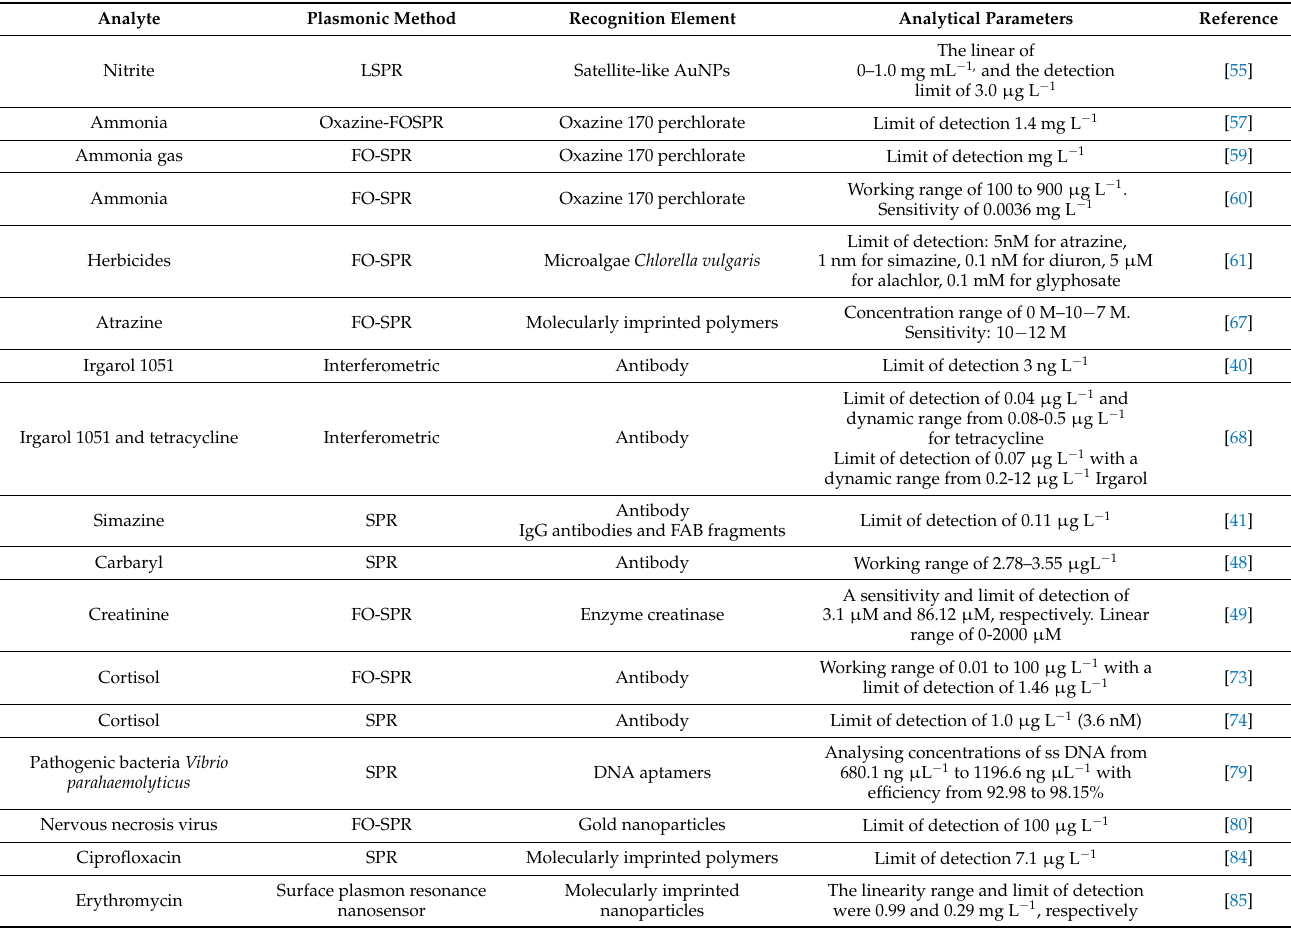
Table 2. Plasmonic approaches for sensing applications in